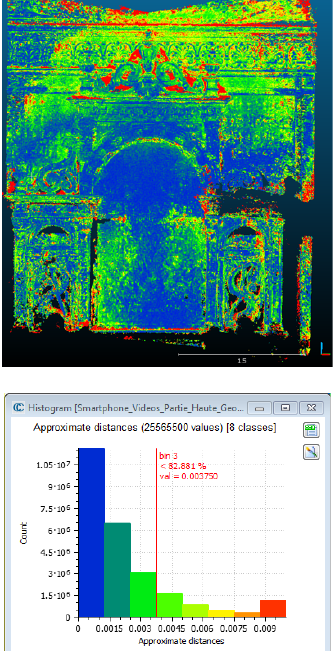
Figure 5. Histogram of the number of points according to the laser-point distance (bottom) and associated 3D map